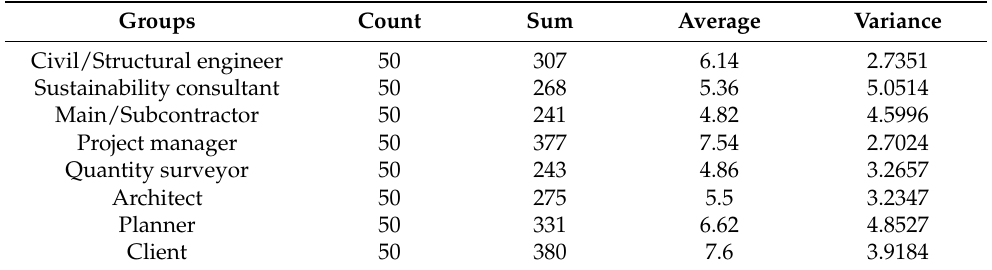
Table 4. One-way ANOVA influence of construction sector professionals over the selection of materials.